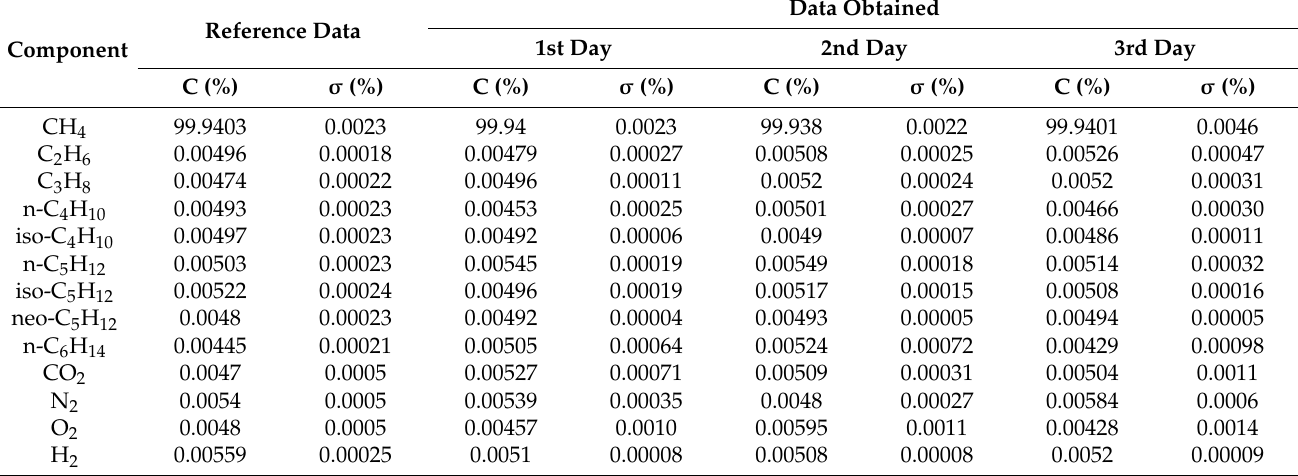
Table 3. Measurement results for sample